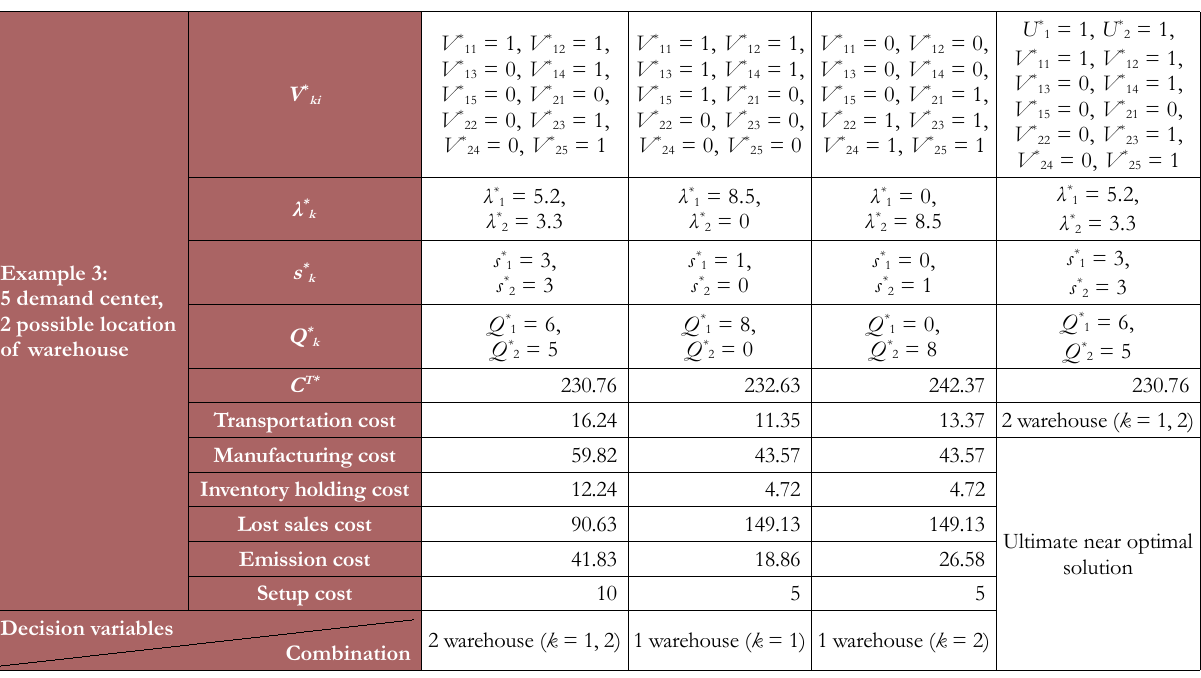
Table 5. Solutions of example 1, 2, and 3: Near optimal